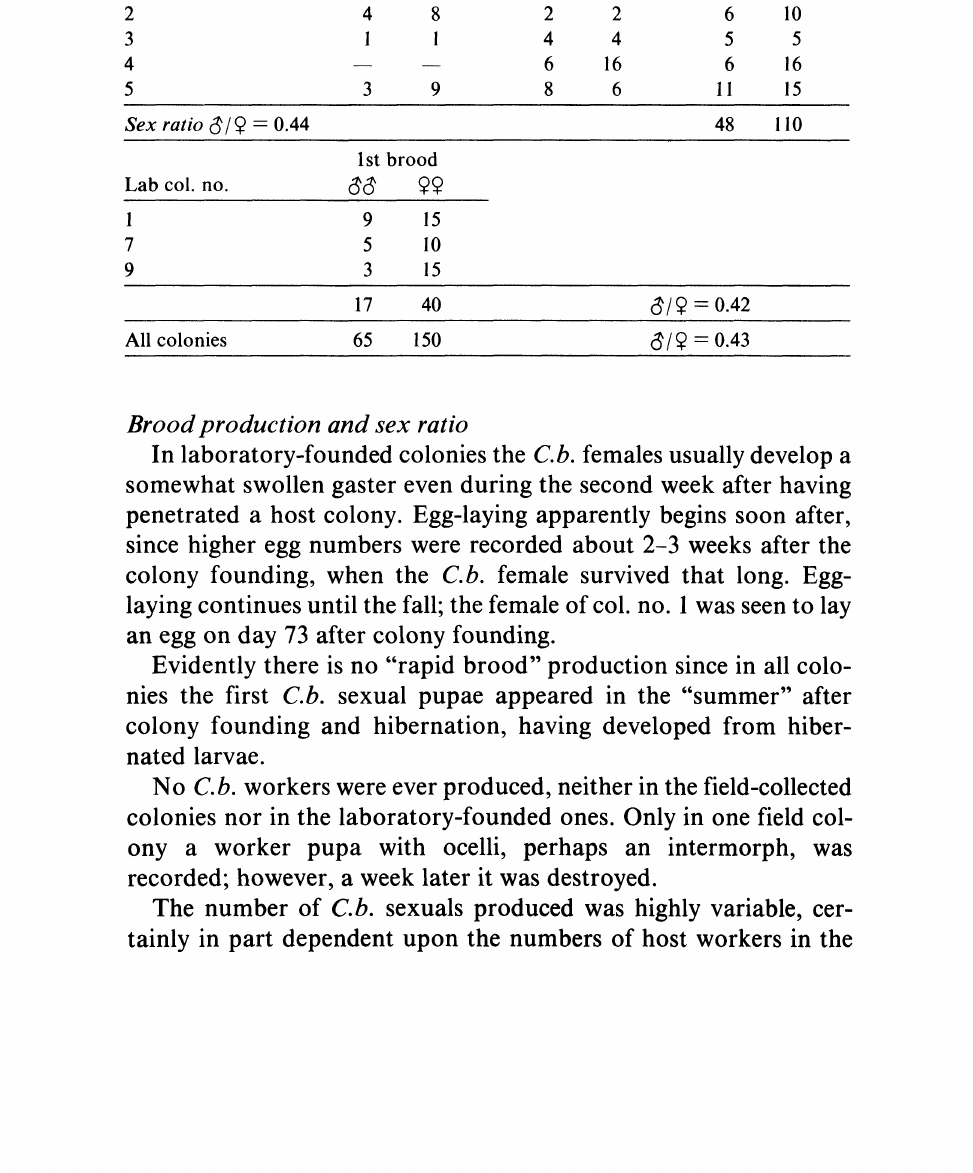
Tab. 2. Production of five Chalepoxenus brunneus colonies collected in the field (lst brood May/June, 1987; 2nd brood in April, 1988) and three founded in the laboratory (lst brood in April,